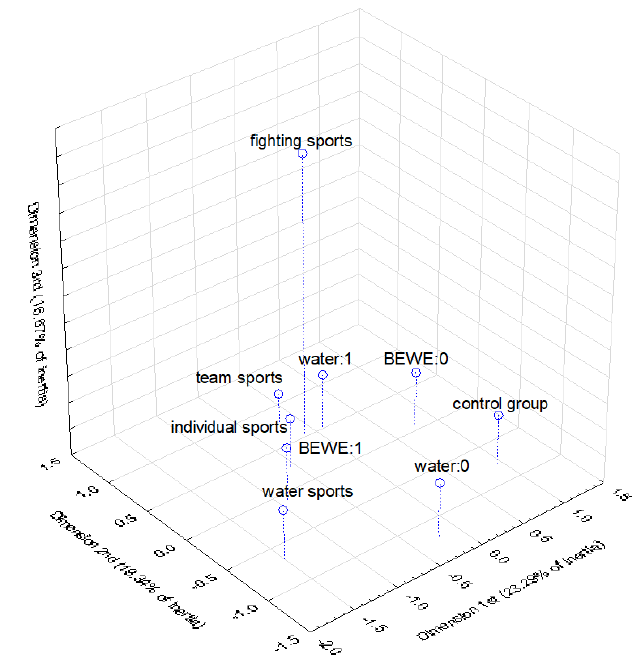
Figure 5. Multidimensional correspondence analysis—3-dimensional